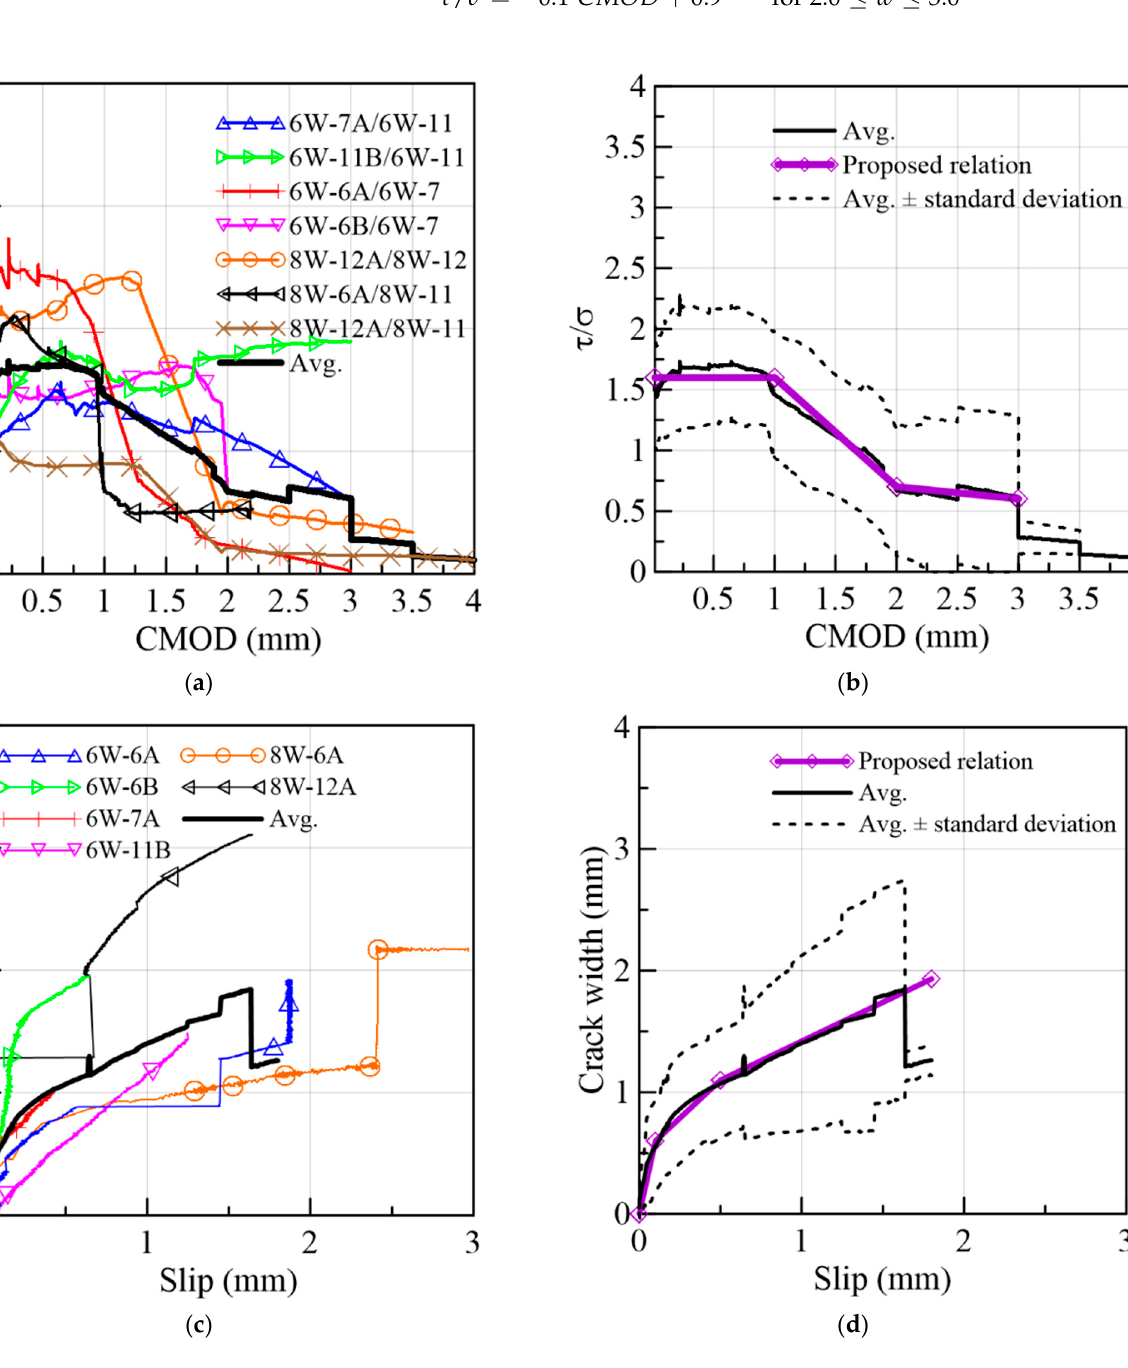
Figure 27. Shear/flexural tensile stress ratios vs. CMOD from ( a ) selected specimens, ( b ) proposed crack dilatancy law, ( c ) crack width–slip relation and ( d ) proposed crack width–slip relation. In addition, a relation between the crack width ( 𝑤 ) and slip ( 𝑠) was established from